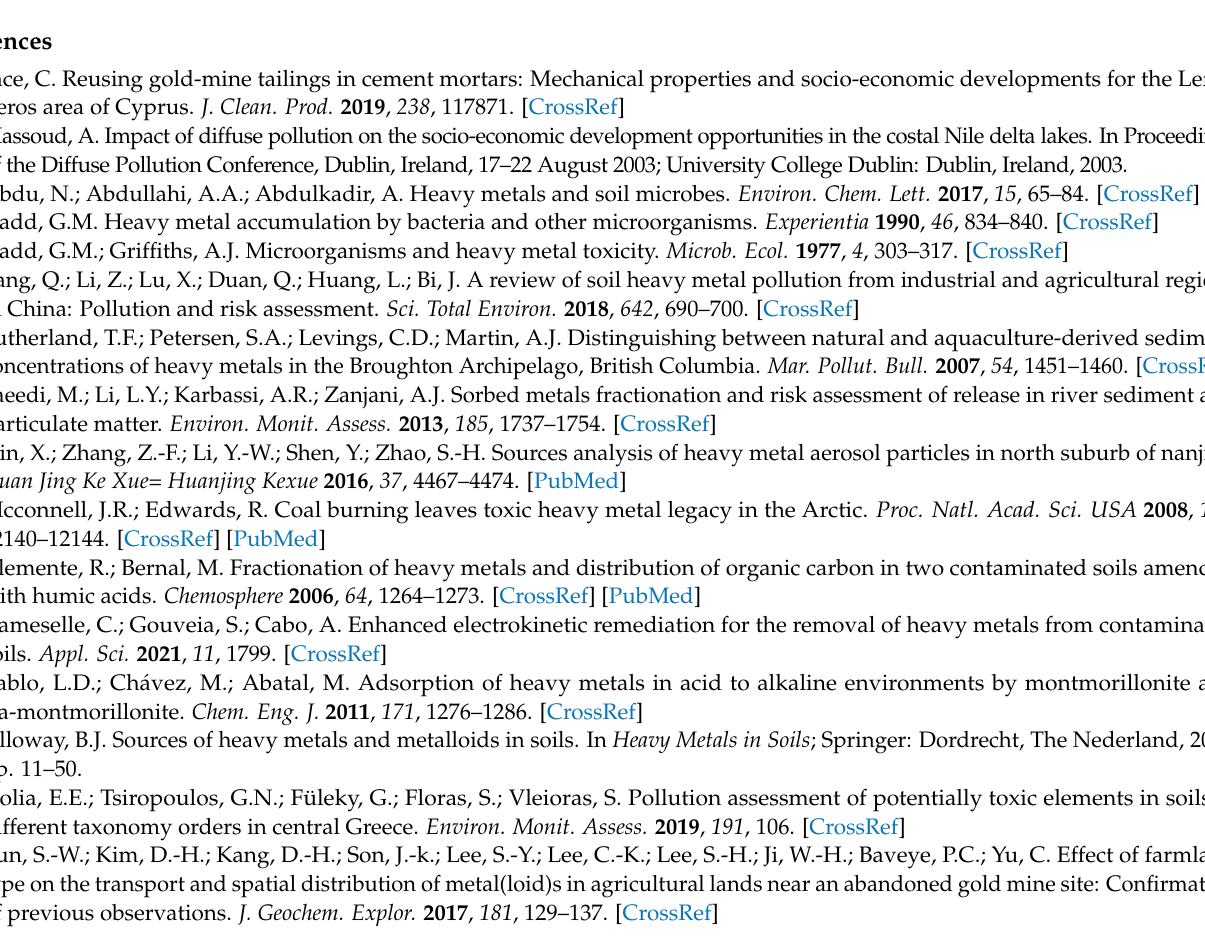
Note: “ND.” means not